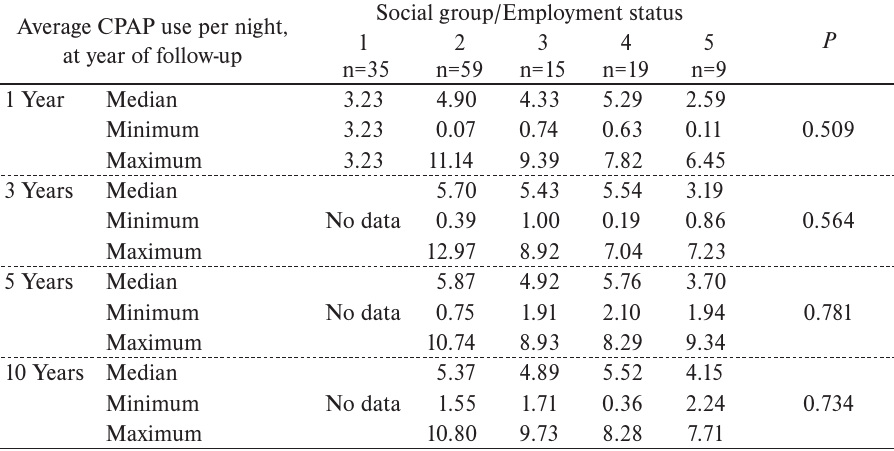
Table 3. CPAP adherence in different social groups – differences between groups in the average length of CPAP use per night. Social group/Employment status Average CPAP use per night, at year of follow-up